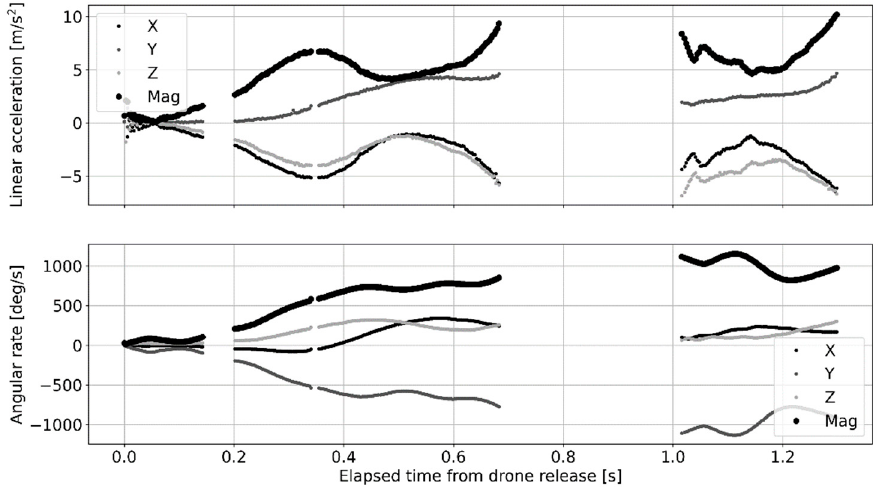
Figure 16. TA2 linear acceleration and rotation rate for 0 < t < 1.3 s.